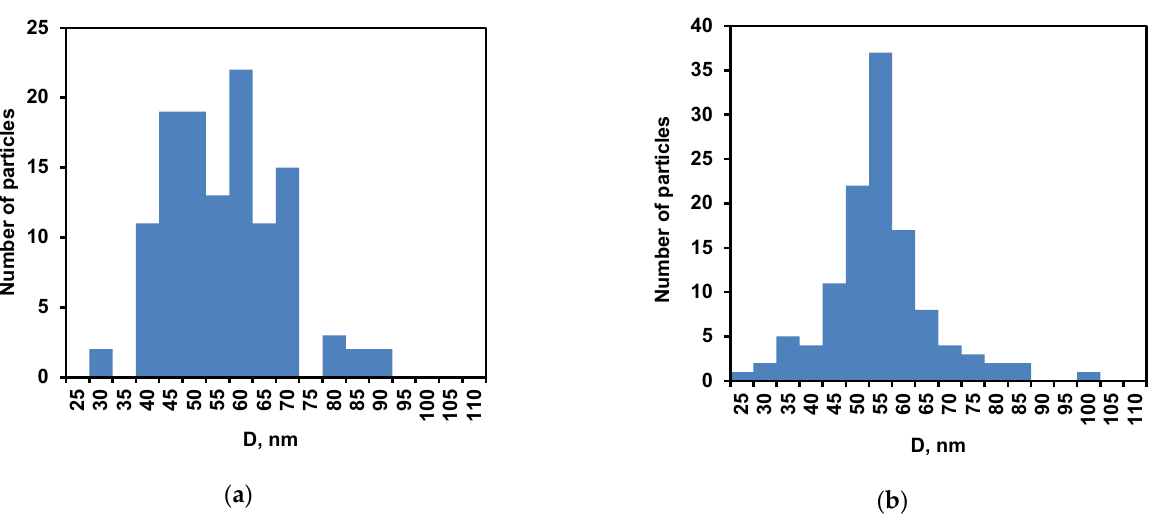
trypsin and ( b ) sample 2 obtained by inhibiting the enzyme with soybean trypsin inhibitor.